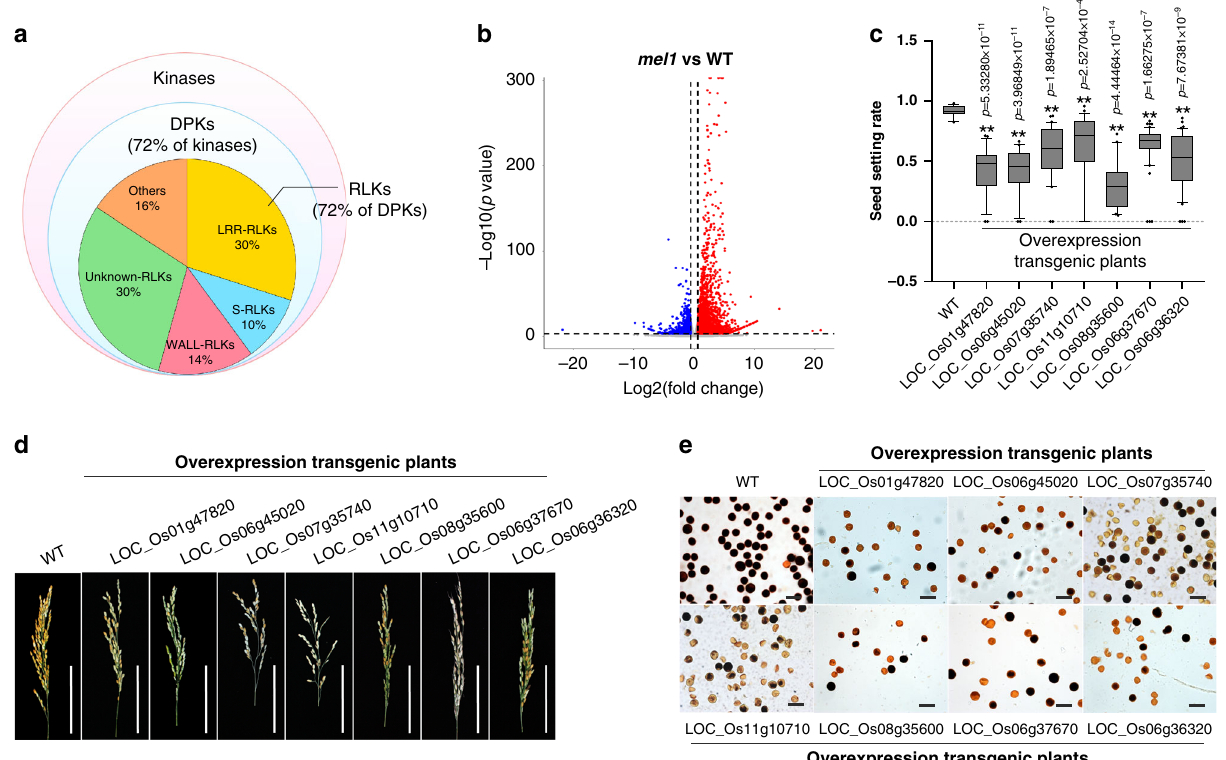
Fig. 2 Reproductive phasiRNA target genes that negatively regulate sporogenesis. a Pie charts showing the categories of the kinases targeted by reproductive phasiRNAs. b Volcano plots of the global gene expression pattern in mel1 and wild-type (WT) spikelets at the PPS. Red spots represent genes that upregulated in mel1 , and blue spots represent genes that downregulated in mel1 . c Seed-setting rate of WT and different transgenic plants. Each target gene was overexpressed independently. Box plots indicate median (middle line), 25th, 75th percentile (box) and 10th and 90th percentile (whiskers) as well as outliers (single points). ( n = 15, 23, 20, 38, 26, 23, 50, and 42 plants from left to right, respectively). Signi fi cant differences were identi fi ed at the 5% (*) and 1% (**) probability levels using two-tailed paired t -test. d Panicles of WT and different transgenic plants. Scale bars = 10 cm. e Pollen